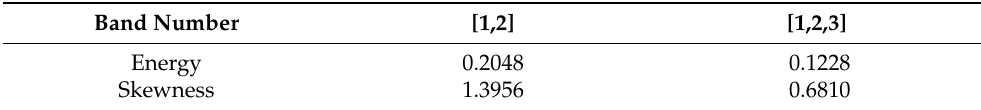
Table 1. For the simulation data with 3 bands, the comparison of the average filter output energy and the absolute value of the skewness using different L s. Band Number